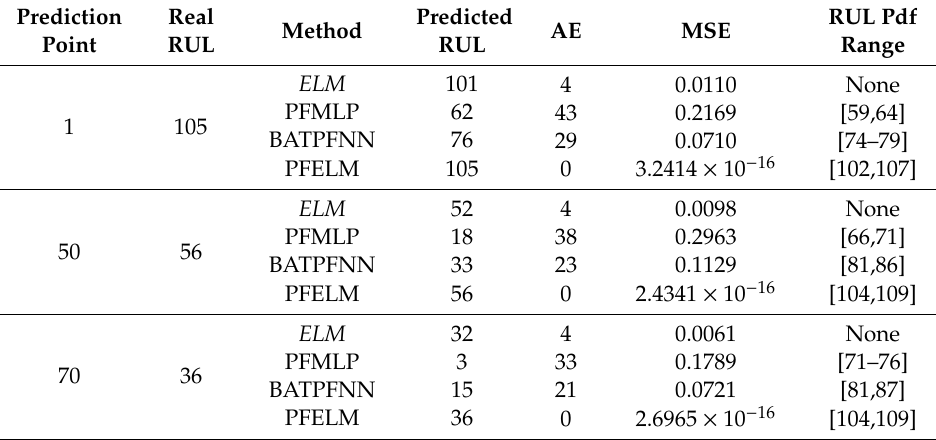
Table 3. Comparison of Prognosis Results of B0006.